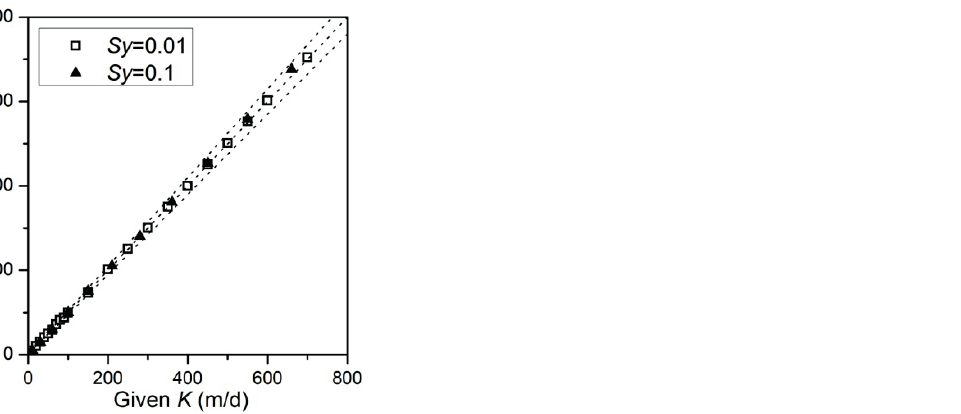
Fig. 3 Verification of the determination of hydraulic conductivities with S y = 0.01 and S y = 0.1 in a homogenous aquifer. Top and bottom dash lines represent the 1.05 times and the 0.95 times the given value,